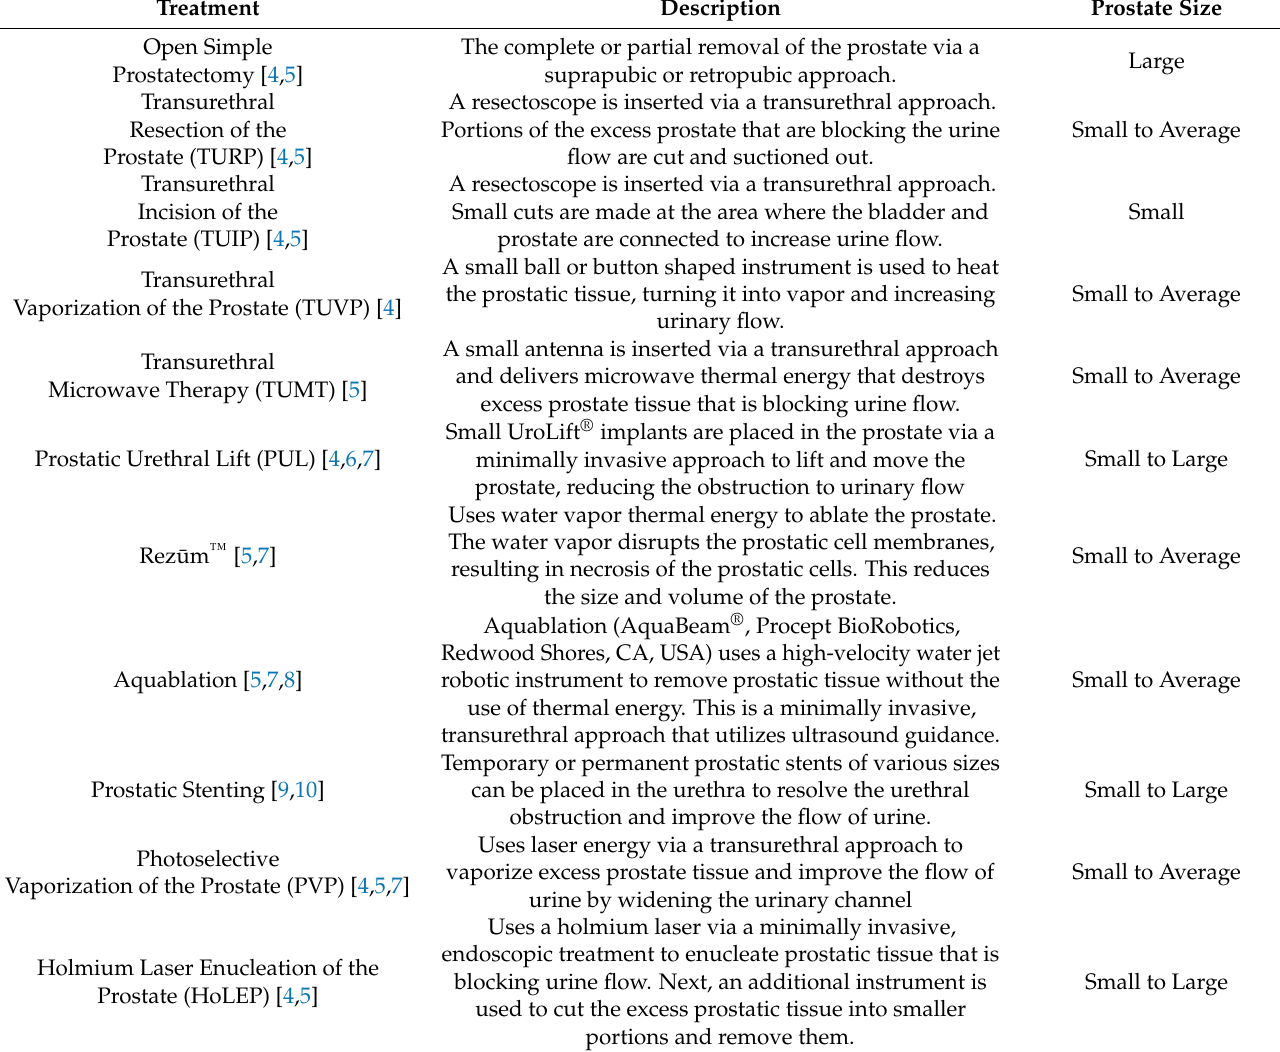
Table 1. Current surgical and minimally invasive treatment options for BPH. Prostate size range is as follows. small: <50 g, average: 50–80 g and large: >80 g